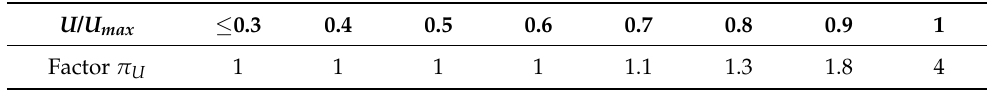
Table 1. Factor π U for